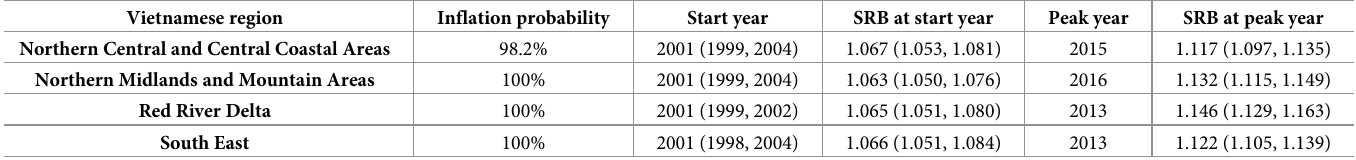
Table 2 summarizes the model results of the analysis of SRB imbalances over time. We provide estimates of the schedule and intensity of these imbalances among the regions identified by our modeling as having skewed SRB levels. Four out of the six regions are identified as having an existing sex imbalance at birth: Northern Midlands and Mountain Areas, Northern Central and Central Coastal Areas, Red River Delta, and South East. For the Northern Midlands and Mountain Areas, Red River Delta, and South East, the model estimates a 100% probability of having SRB inflation. Meanwhile, it also suggests that the probability of a sex ratio transition is 98.2% for the Northern Central and Central Coastal Areas. The start year of SRB inflation is estimated at around 2001 for the four regions with a 95% credible interval around 4 to 6 years’ Table 2. SRB imbalance in Vietnam by